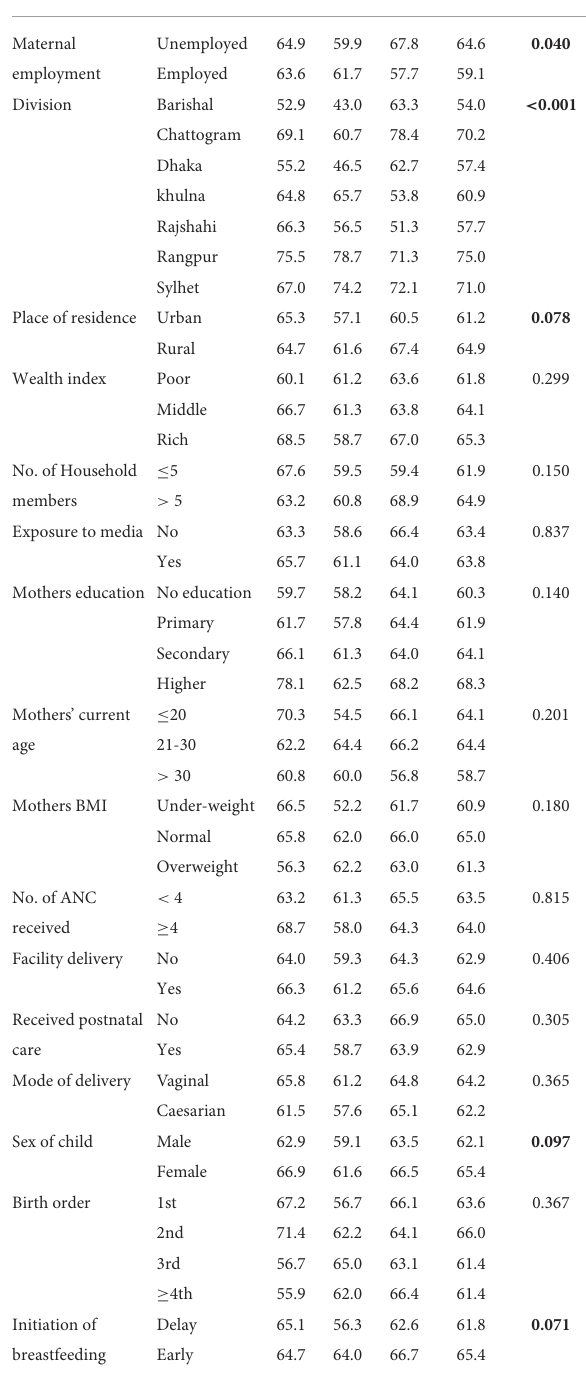
TABLE 2 Prevalence of exclusive breastfeeding (EBF) by different background characteristics. p -values were generated from the chi-square test of pooled (2011–2017)